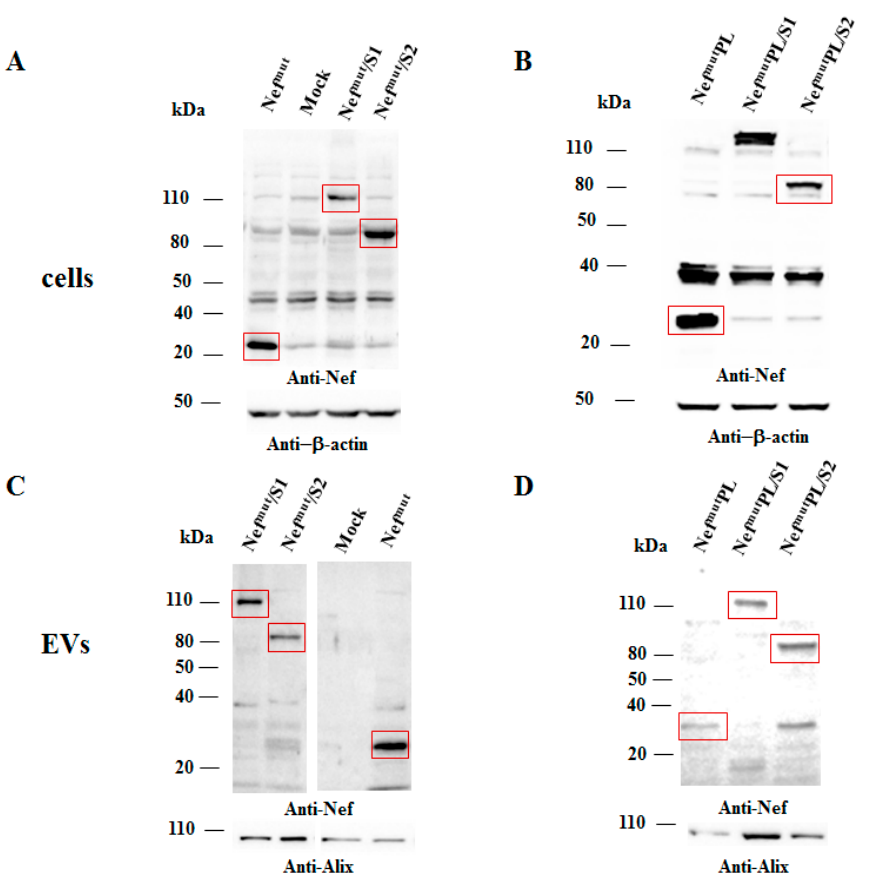
Figure 5. Detection of SARS-CoV-2 S1- and S2-based fusion products in transfected cells and EVs. Western blot analysis on 30 µg of lysates from HEK293T cells transfected with DNA vectors expressing either Nef mut or Nef mut PL fused with either SARS-CoV-2 S1 or S2 ORFs ( A , B ). Equal volumes of the buffer where purified EVs were resuspended after differential centrifugations of the respective supernatants were also analyzed ( C , D ). As a control, conditions from mock-transfected cells, as well as cells transfected with Nef mut PL expressing vector, were included. Polyclonal anti-Nef Abs served to detect Nef mut -based products, while β -actin and Alix were revealed as markers for cell lysates and EVs, respectively. Where relevant, specific signals are highlighted. Molecular markers are given in kDa. The results are representative of two independent experiments.